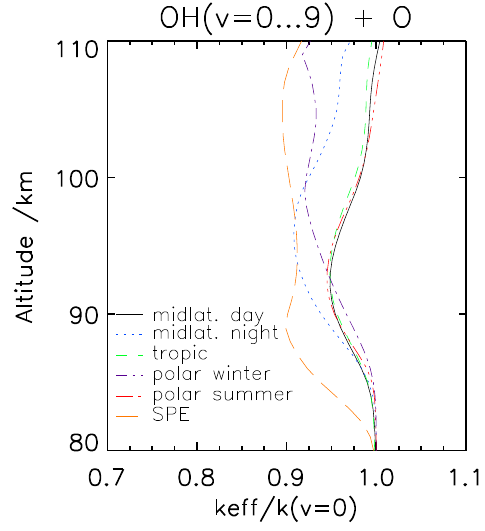
Fig. 10. Relative increase of the total OH( v = 0 ... 9 )+O rate co- efficients by consideration of vibrational excitation of OH in the reaction OH+O as a function of altitude for various atmospheres.